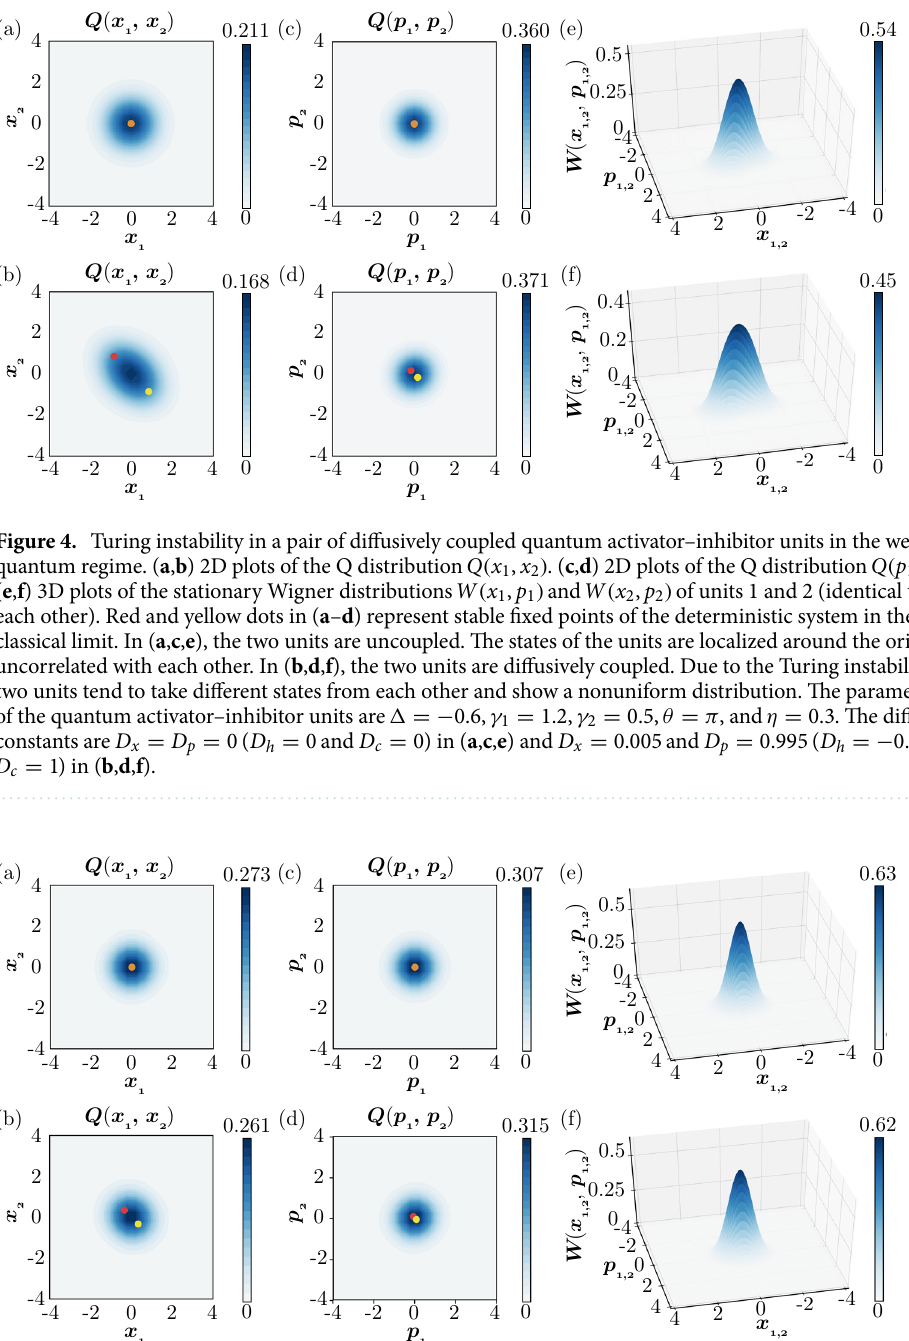
Figure 5. Turing instability in a pair of diffusively coupled quantum activator–inhibitor units in the strong quantum regime. ( a , b ) 2D plots of the Q distribution Q ( x 1 , x 2 ) . ( c , d ) 2D plots of the Q distribution Q ( p 1 , p 2 ) . ( e , f ) 3D plots of the stationary Wigner distributions W ( x 1 , p 1 ) and W ( x 2 , p 2 ) of units 1 and 2 (identical to each other). Red and yellow dots in ( a – d ) represent stable fixed points of the deterministic system in the classical limit. In ( a , c , e ), the two units are uncoupled. The states of the units are localized around the origin and uncorrelated with each other. In ( b , d , f ), the two units are diffusively coupled. Due to the Turing instability, the two units tend to take different states from each other and show a nonuniform distribution. The parameters 0.3 . The diffusion 0.6, γ 1 6.2, γ 2 3, θ π , and η of the quantum activator–inhibitor units are � = = − = = = 0 ) in ( a , c , e ) and D 0.005 and D 0 ( D 0.995 ( D 0 and D 0.99 and D p constants are D x c = x = p = h = h = − = = 1 ) in ( b , d , f D c =